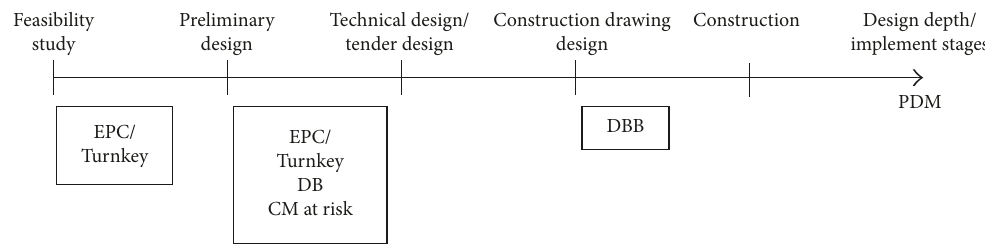
Figure 1: PDM spectrum. Note: the scope of each PDM is from the left point of the coordinate PDM.